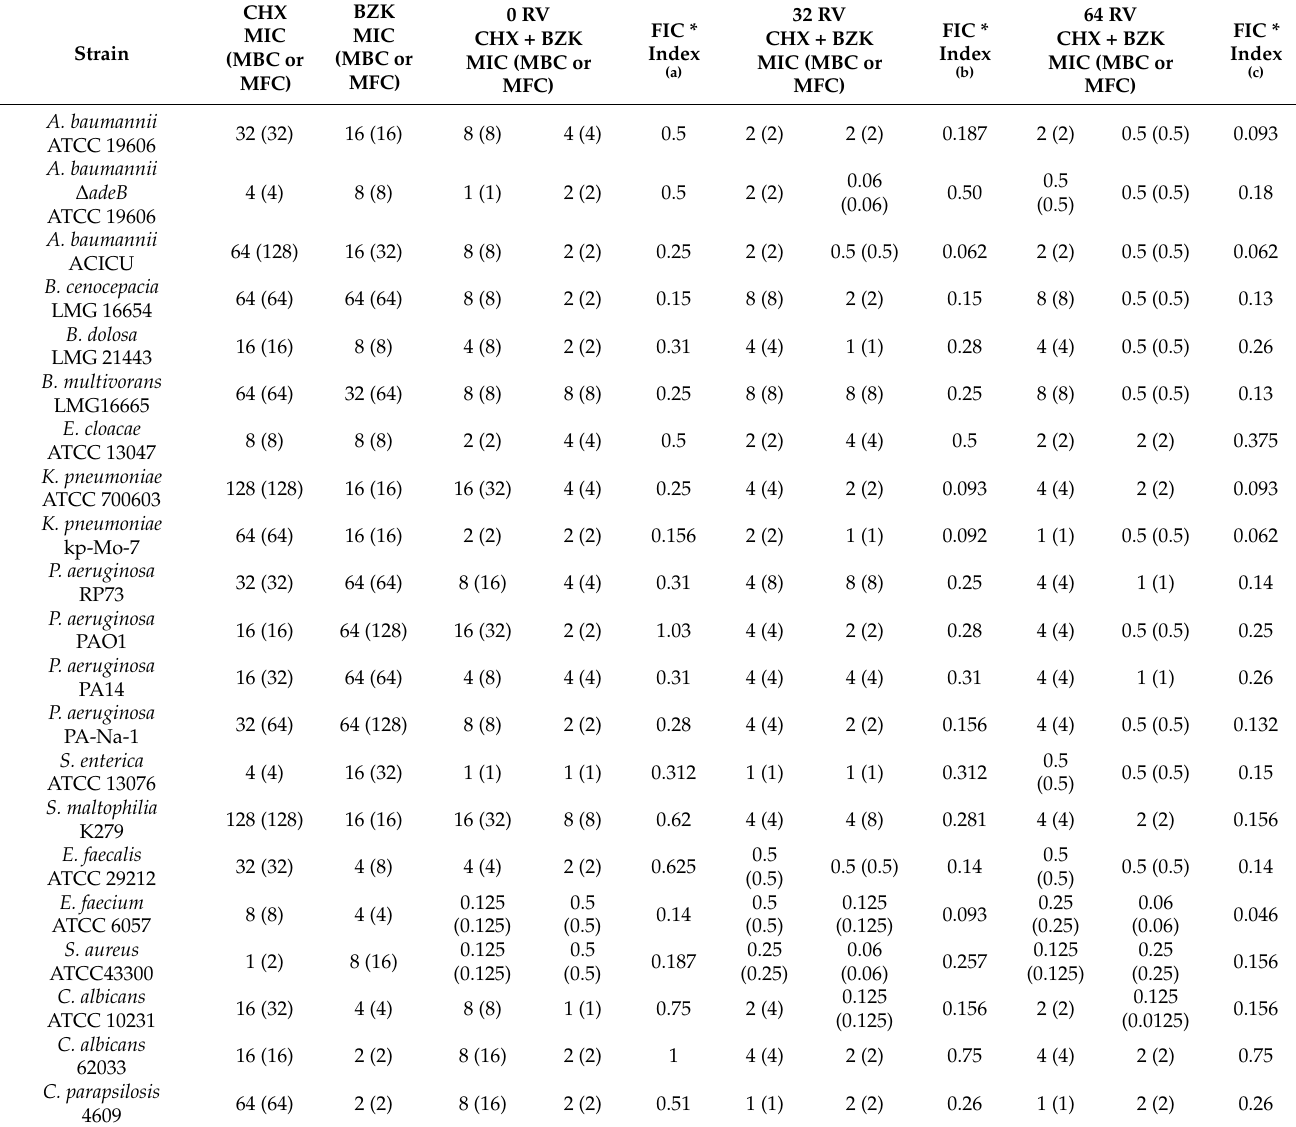
Table 4. Effect of RV (mg/L) on CHX and BZK MIC (mg/L) and MBC (MFC in the case of